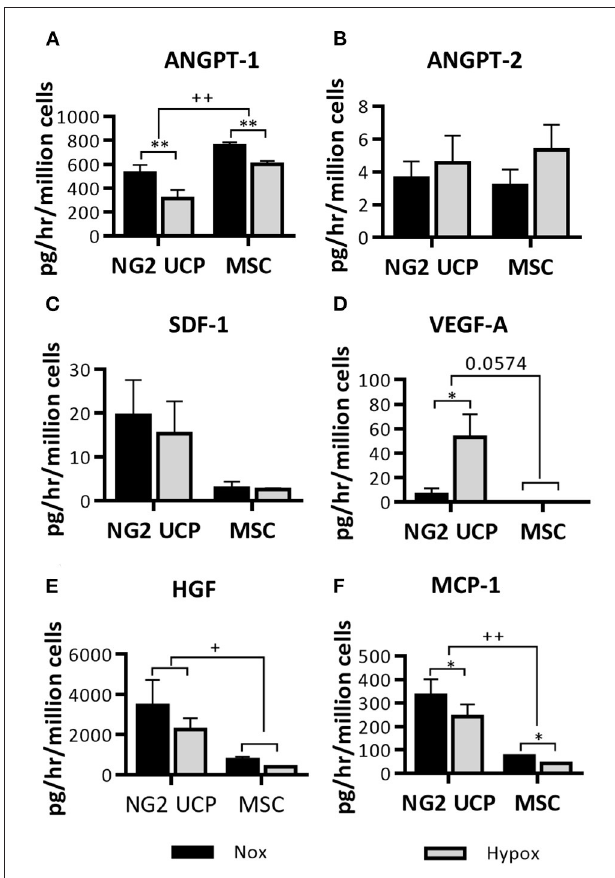
FIGURE 5 | Characterization of the NG2 UCP secretome. (A–F) Analysis of cell-secreted factors in cell-conditioned media, normalized for the volume of the collected supernatant, time of incubation and cell number. ANGPT-1, angiopoietin 1; ANGPT-2, angiopoietin; SDF-1, stromal derived factor 1; VEGF-A, vascular endothelial growth factor A; HGF, hepatocyte growth factor; MCP-1, monocyte chemoattractant protein 1. Data represent means ( ± S.E.M). MSCs n = 3, NG2 UCPs n = 6; * / + p < 0.05 and ** / ++ p < 0.01. *represents differences between hypoxia and normoxia, + represents differences between cell